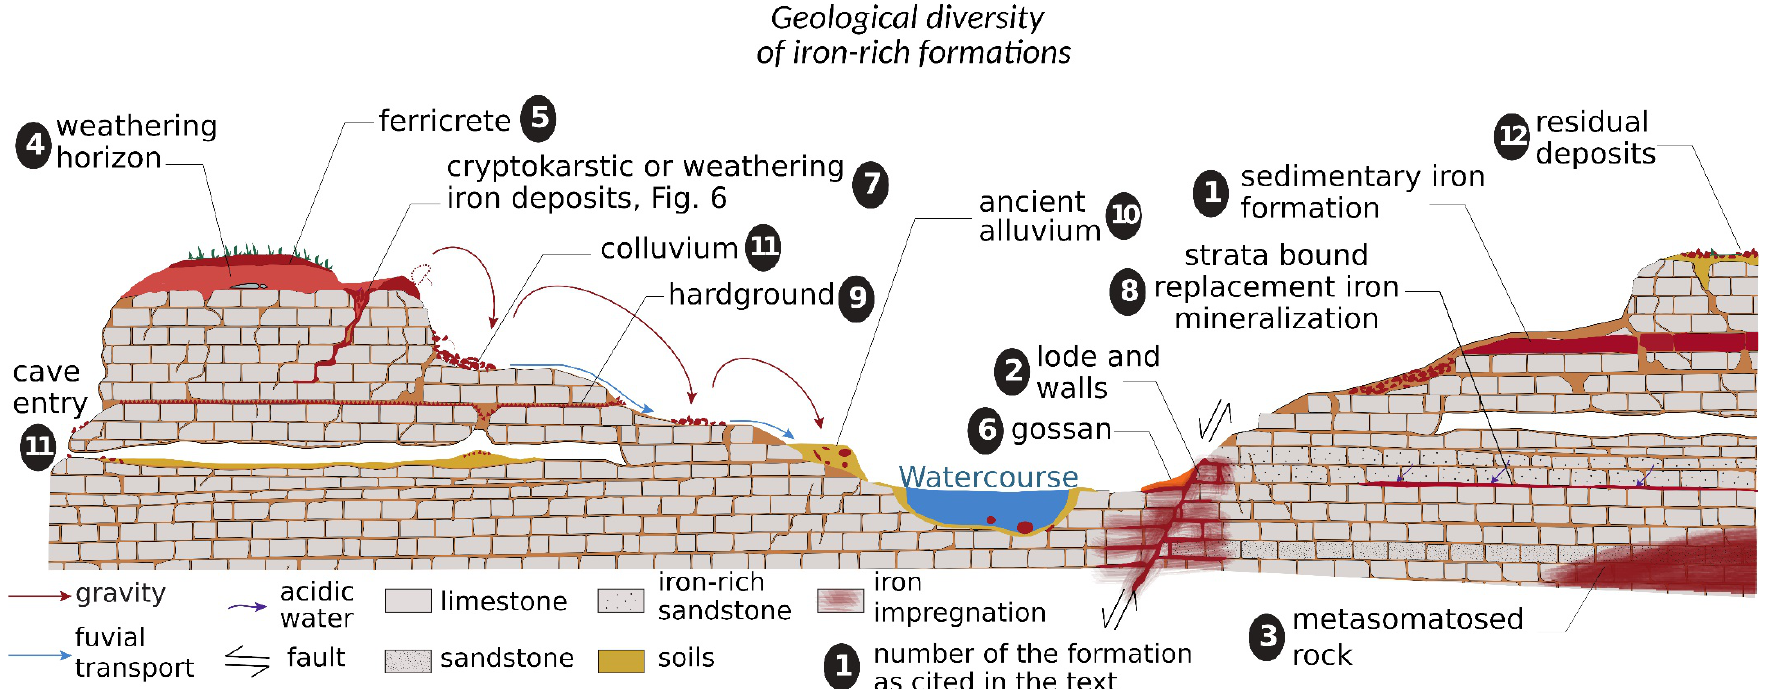
Figure 1. Diversity of iron formations and evolution of deposits. Without attempting to be comprehensive, this diagram shows the main types of formation and most important weathering situations, in order to illustrate the idea of an evolutionary chain (Fernandes & Raynal 2006). Diagram: C. Chanteraud and A. Chassin de Kergommeaux, modified after Chanteraud (2020: